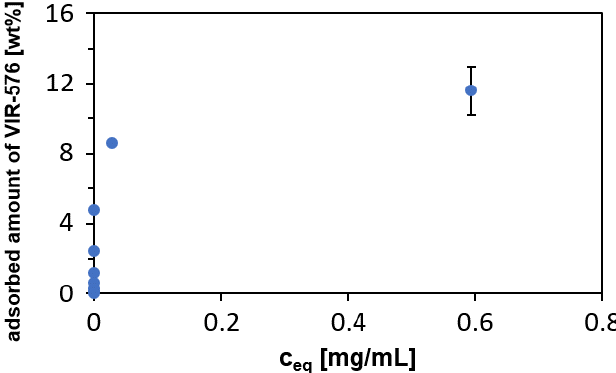
Figure 2. Adsorption isotherm of VIR-576 adsorbed onto MSNs from PBS (pH = 7.2). Particle concentration: 5 mg/mL, temperature = 25 °C, and incubation time = 1 h.